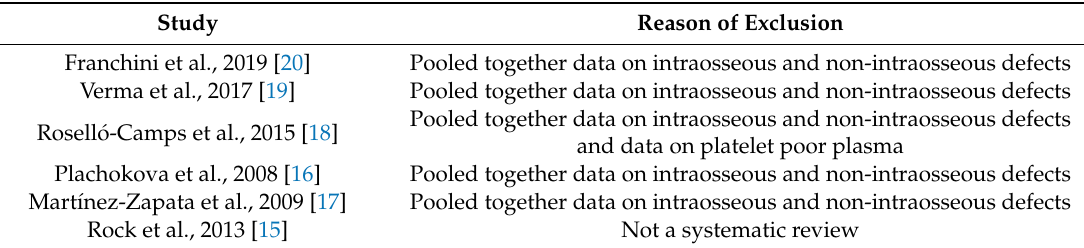
Table 2. Excluded articles with reason of